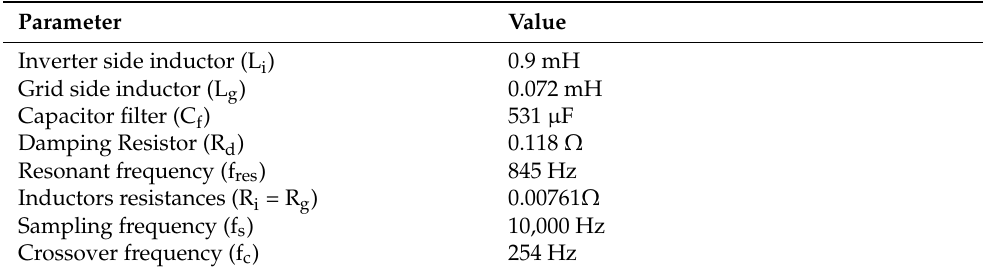
Table 5. Filter parameters